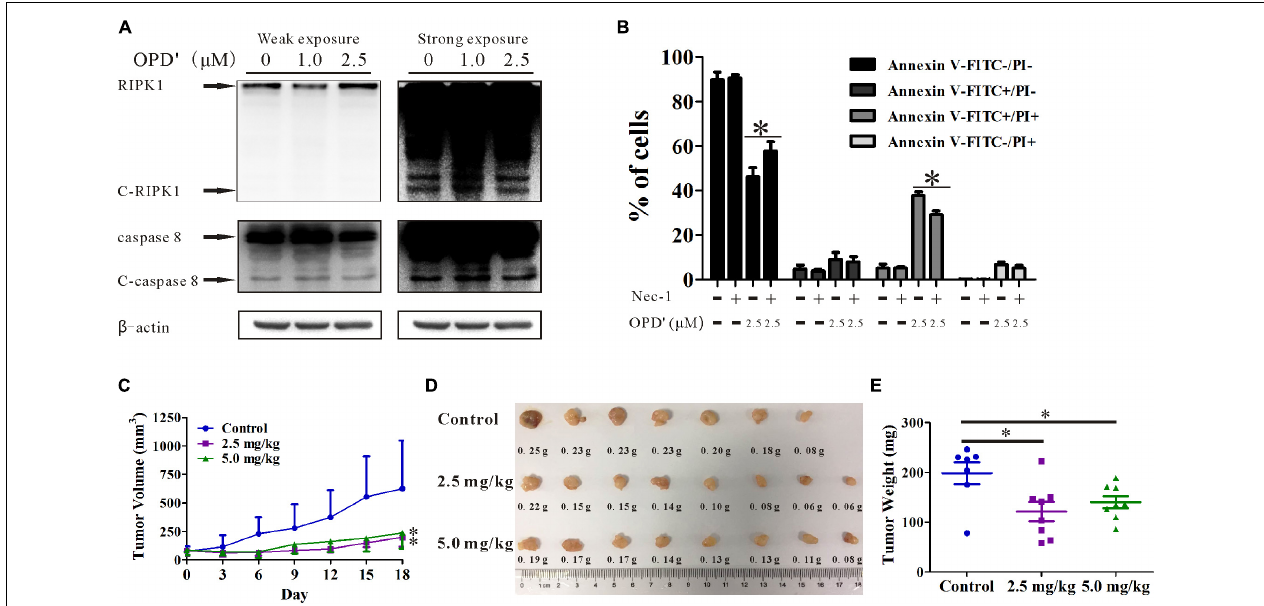
FIGURE 6 | The effects of OPD (cid:48) on DU145 prostate cancer cells in vitro and in vivo. (A) DU145 cells were exposed to various concentrations of OPD (cid:48) for 6 h, then the protein levels of RIPK1, C-PIPK1, caspase-8, and C-caspase 8 were examined by Western blotting. n = 3 independent experiments; this panel represents one of the replicates. (B) After pre-treatment with 10 µ M Nec-1 for 2 h, the cells were exposed to various concentrations of OPD (cid:48) for 18 h, followed by the Annexin V-FITC/PI assay. Data are presented as the means ± SD; n = 3 independent experiments. ∗ p < 0.05 vs. 2.5 µ M OPD (cid:48) alone. (C) The tumors were measured every 3 days to assess their growth. OPD (cid:48) was injected i.p. at doses of 2.5 and 5.0 mg/kg/d, 5 d/wk for 18 days. Each group comprised eight mice. One of the mice in the control group died on Day 12. ∗ p < 0.05 vs. the control group. (D) Representative tumors were weighed and photographed at the end of the experiment. (E) The weight distribution of the tumors at the end of the experiment. ∗ p < 0.05 vs. the control group.